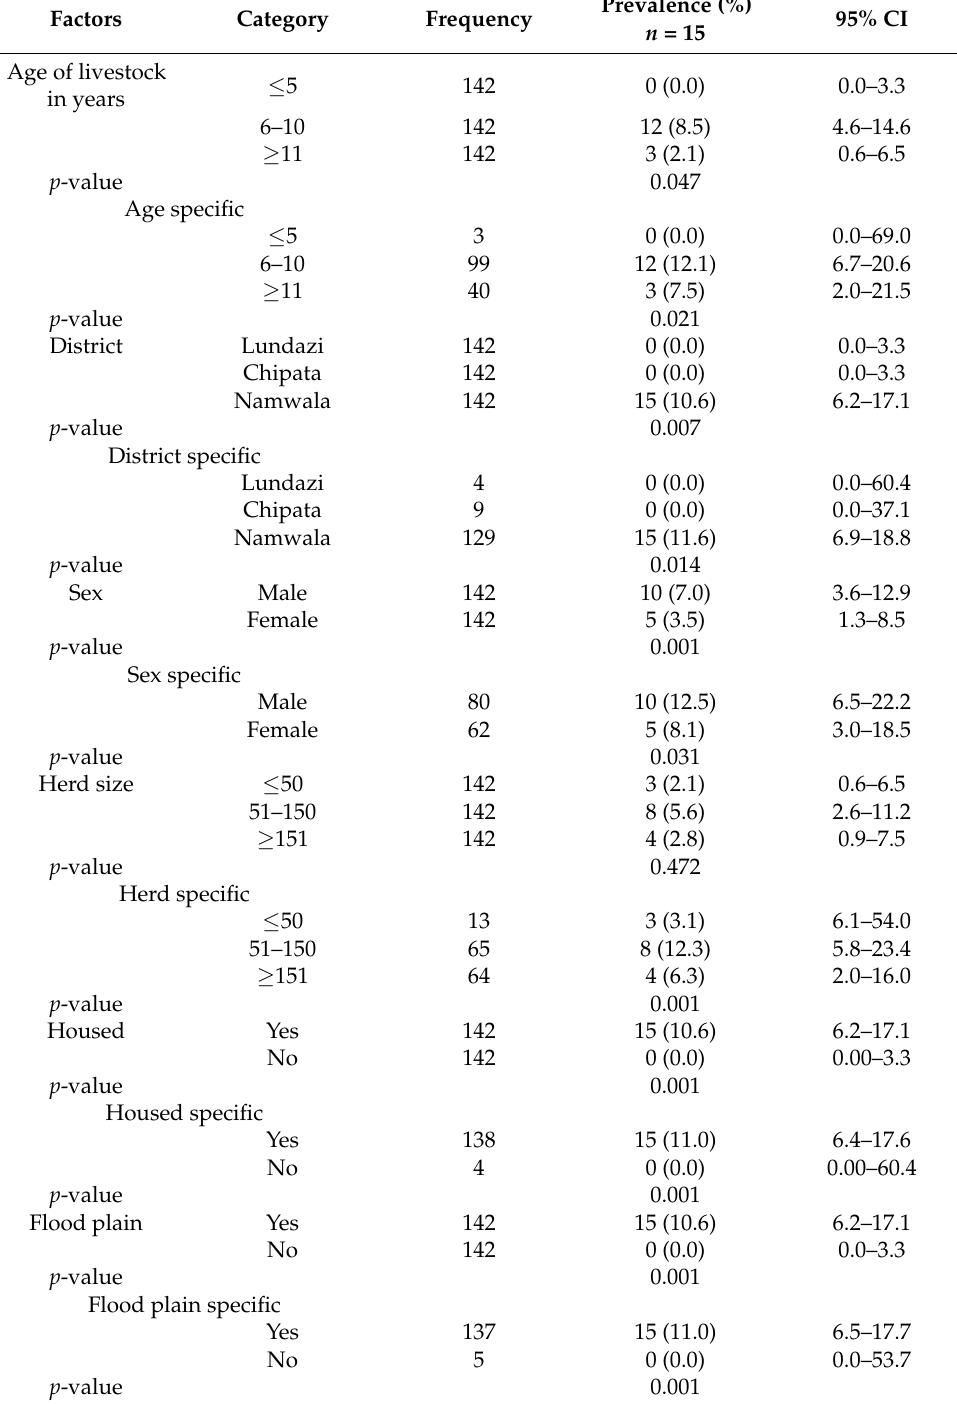
Table 2. Overall and specific prevalence of NTM infection across age, districts, and sex of the cattle.